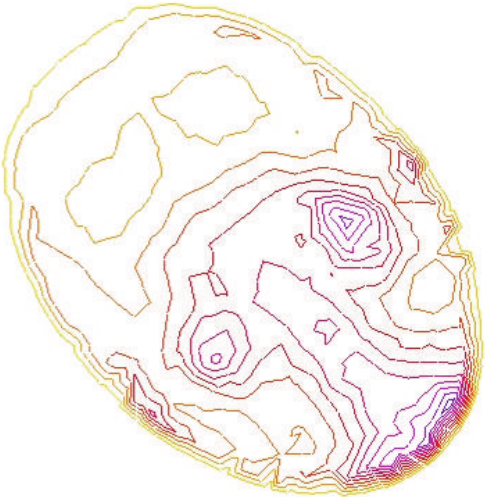
Figure 6: The kinetic energy value spatial distribution area in the objective